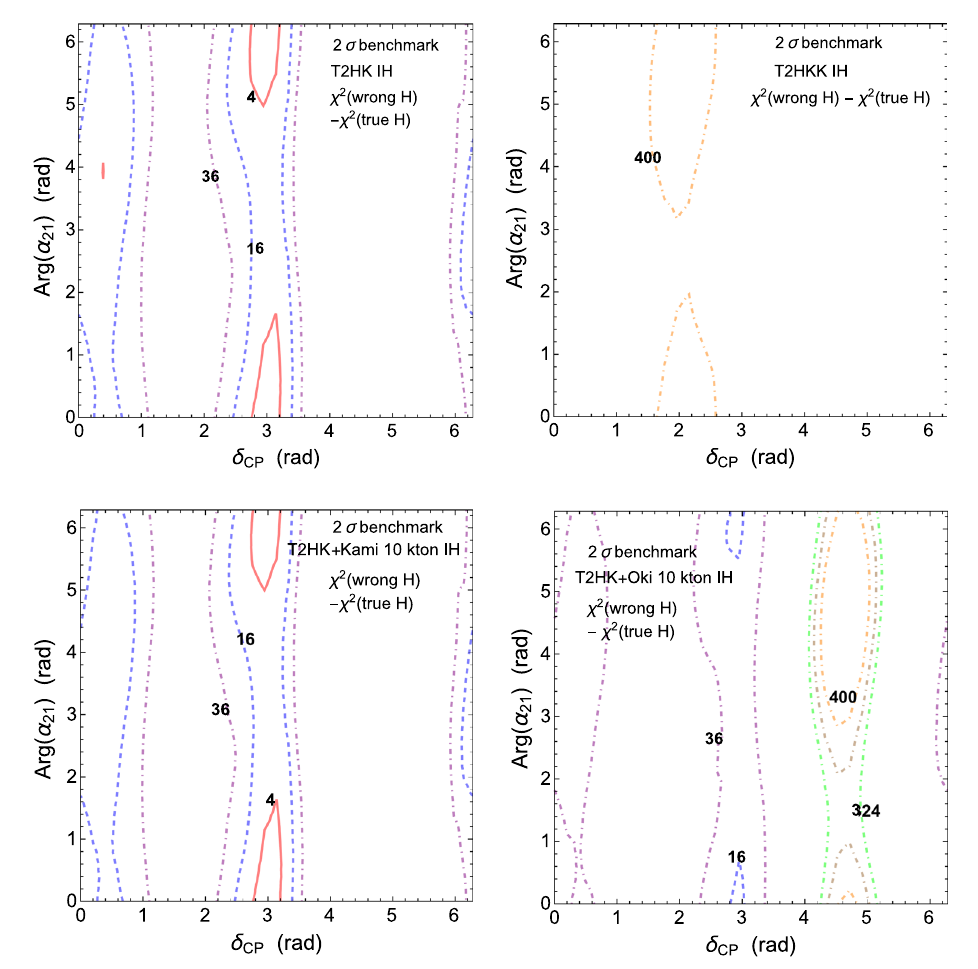
Fig. 15 The difference between the minima (with respect to δ CP only) of χ 2 ((cid:20)) for the wrong and true mass hierarchy, { min χ 2 ( wrong H ) − min χ 2 ( true H ) } . The benchmark with Eq. (37) is assumed, and the true mass hierarchy is inverted. The upper-left, upper-right and lower- right subplots correspond to the T2HK, the T2HKK, and the plan of the T2HK plus a 10 kton water Cerenkov detector at Oki, respec-